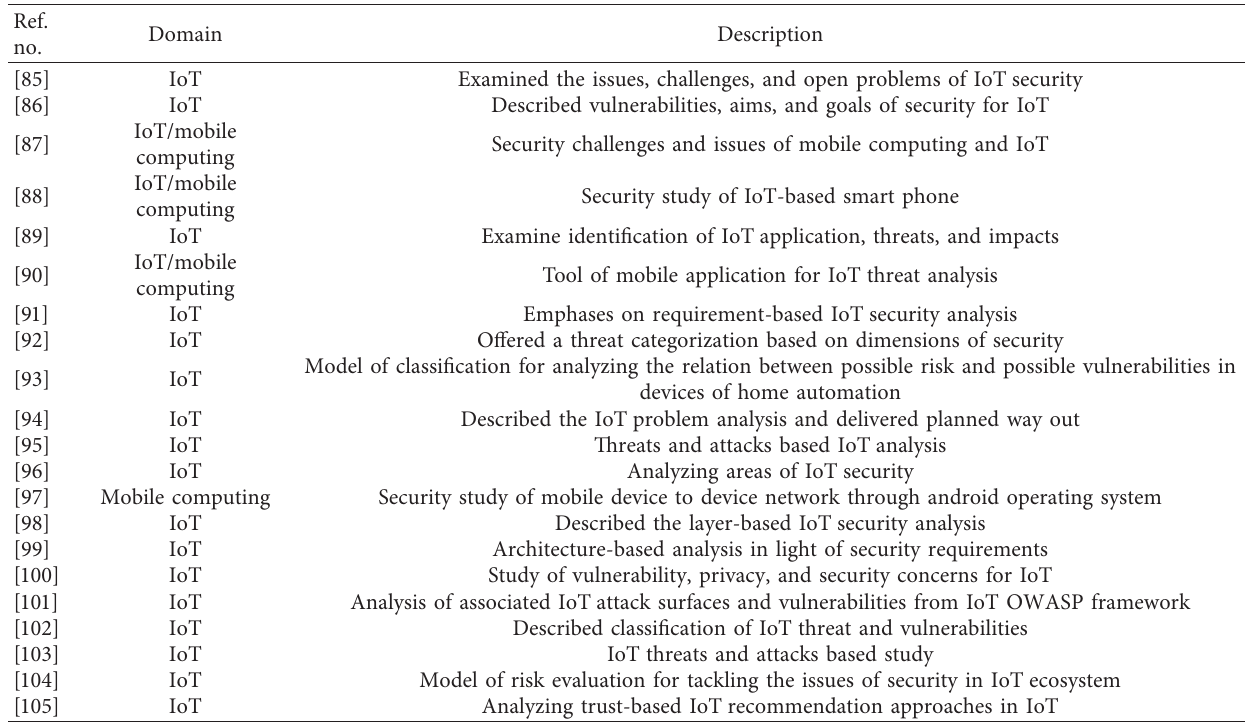
Table 3: Techniques and literature wise categorization.